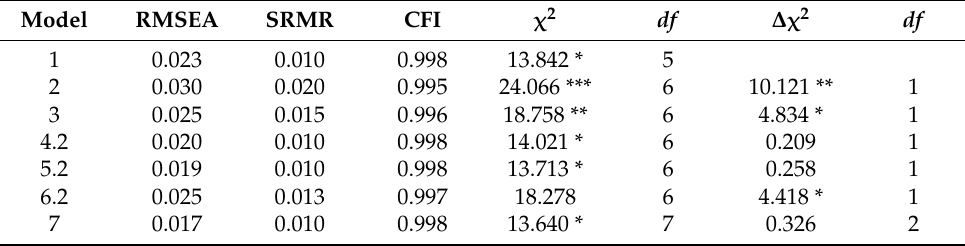
Table 2. Model fit of the random intercept cross-lagged panel models of peer- and parent-related loneliness.